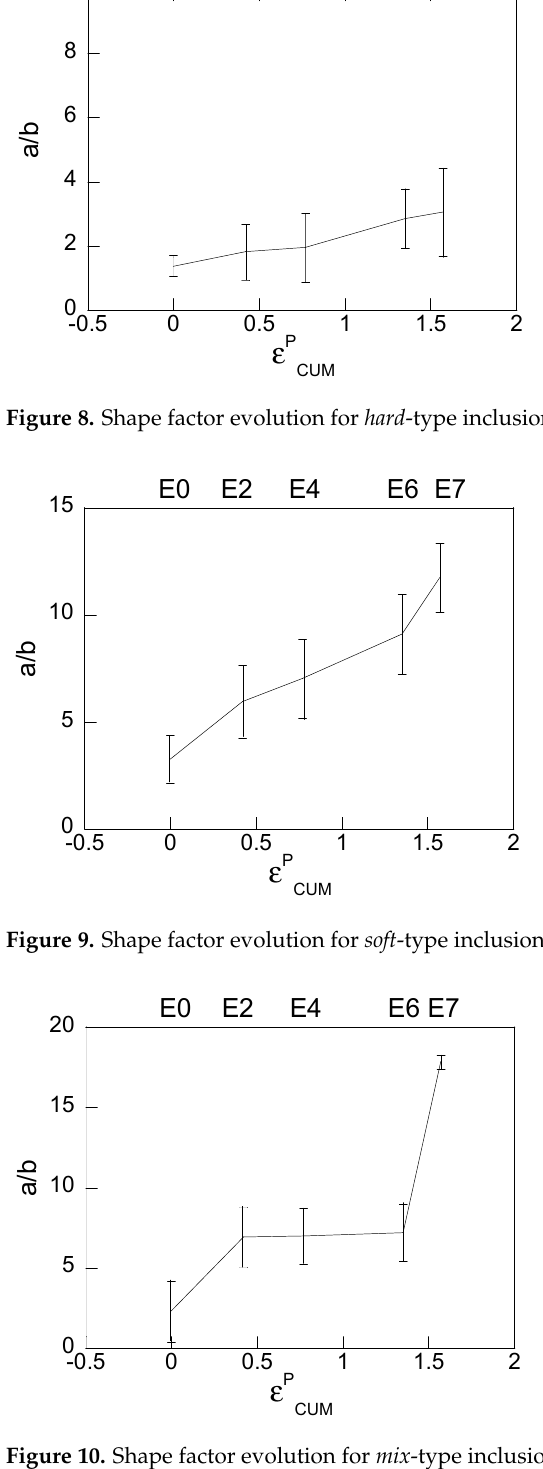
Figure 10. Shape factor evolution for mix -type inclusions.